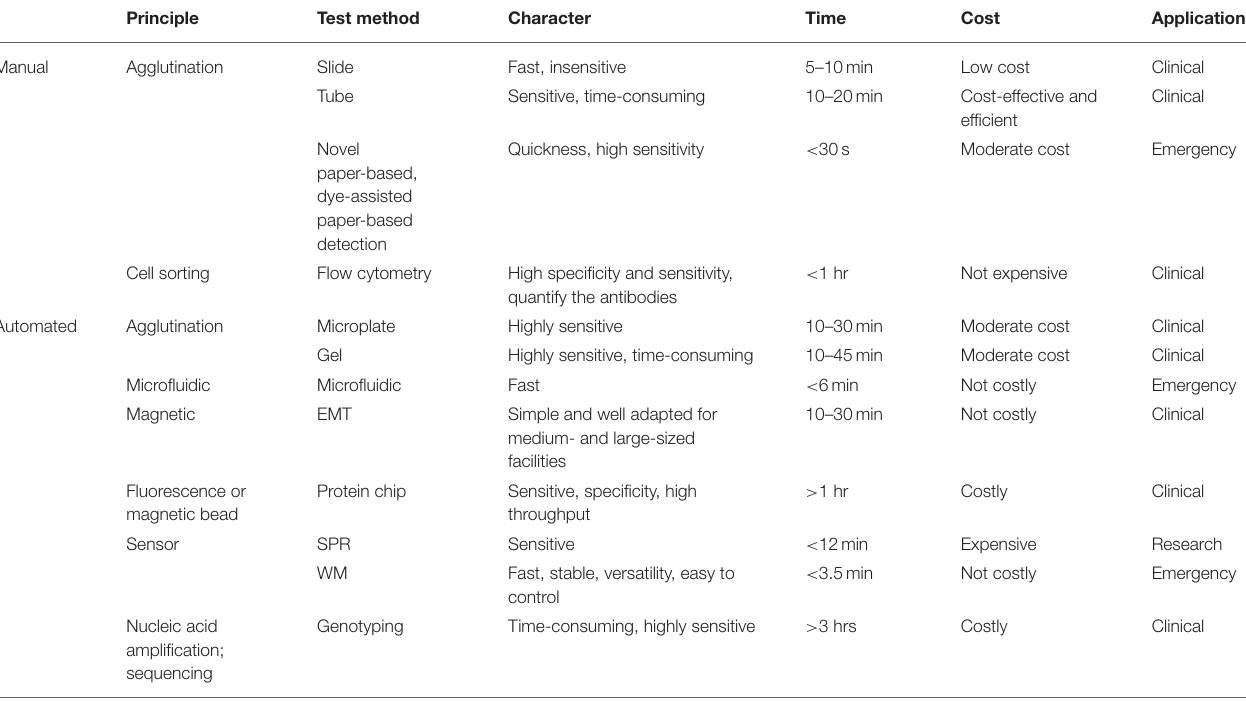
TABLE 2 | The classification and comparison of blood group testing